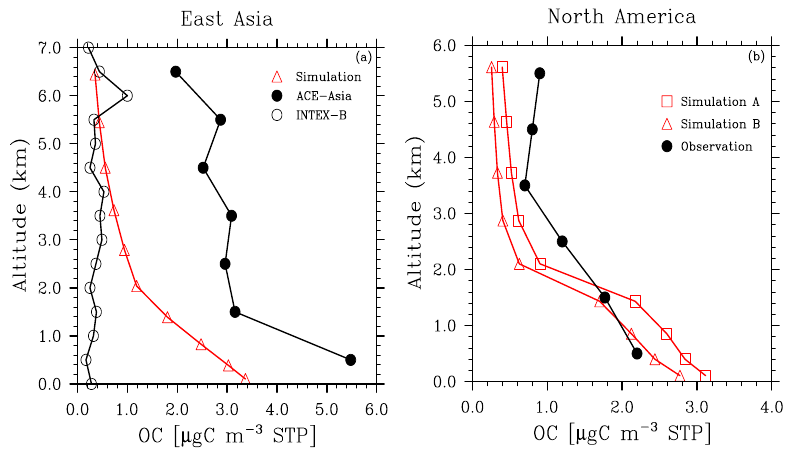
Fig. 8. Mean vertical profiles of total organic carbon at standard conditions of temperature and pressure. Observed mean profiles (black solid circles) were measured during the ACE-Asia campaign at Fukue Island off the coast of Japan in April/May 2001 (left plot) and during the ITCT-2K4 aircraft campaign over NE North America that took place in the Summer (July to August) 2004 (right plot). The black empty circles in the left plot represent average vertical profile of aerosol species for Asian pollution layers measured during the INTEX-B campaign made during April to May in 2006. The model results are the average values over the months of the campaigns. Three simulations produce very similar profiles over East Asia, thus only one simulated profile is shown in (a) . The vertical profile over North America produced in Simulation C is omitted because it is almost identical to that of Simulation